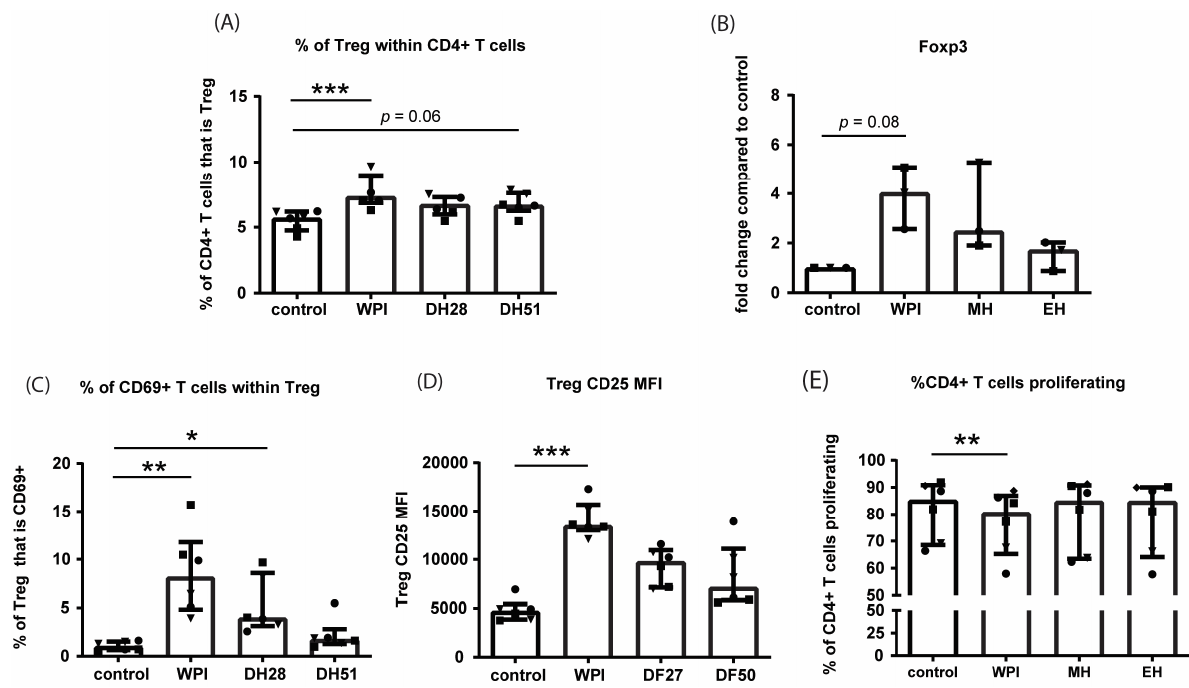
Figure 10. Number and CD25 and CD69 expression of CD4+CD25 high CD127 low Treg in unactivated PBMCs, and proliferation of CD4+ T cells in T cell-activated PBMCs following incubation with WPI, DH28 or DH51. ( A ) The percentage of Treg (CD4+CD25 high CD127 low T cells) within the population of CD4+ T cells in unactivated PBMCs incubated with or without WPI, DH28, or DH51 for 5 days. Data are displayed as median with interquartile range. *** p ≤ 0.001 Results were obtained from three different PBMC donors (depicted by different data point symbols, one symbol type per donor).